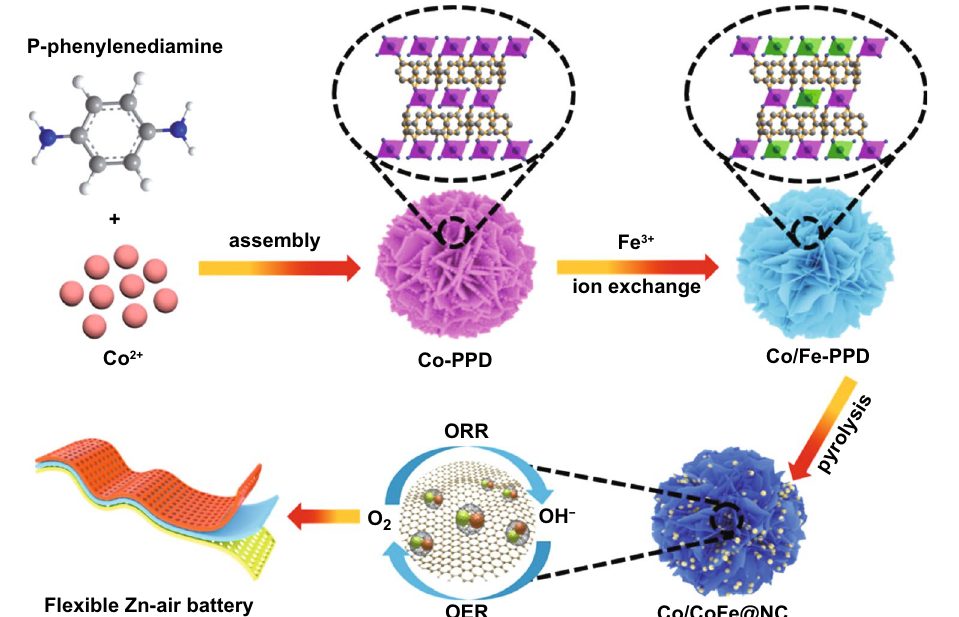
Fig. 1 Schematic illustration of the synthetic route for